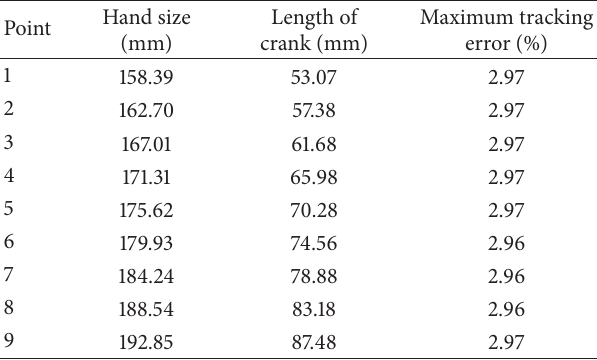
Table 4: Maximum tracking error for different lengths of